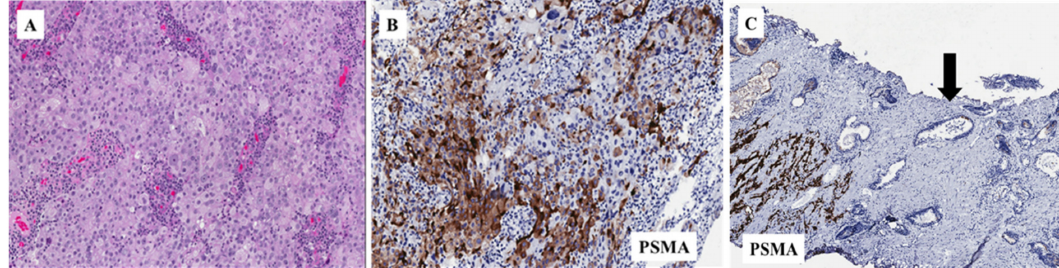
Figure 2. Prostatic adenocarcinoma from a castration-resistant patient ( A : H&E (20 × magnification), positive for PSMA (20 × magnification) ( B ). ( C ): non-neoplastic prostatic glands negative for PSMA staining (arrow) (10 ×